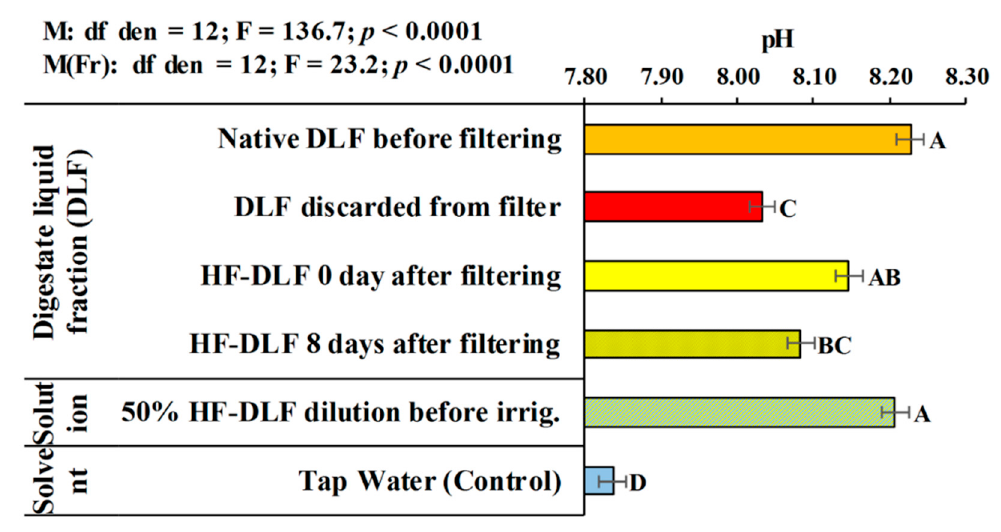
Figure 2. Values of pH of the digestate liquid fraction (DLF), before and after hydrocyclone filtering (HF), the 50% dilution of the HF-DLF, and the tap water used for the experiment. Bares are least square means (LSmeans) ± Lsmeans standard error estimates. Bars with a letter in common cannot be considered different according to a conservative Tukey-grouping applied to the p -differences of the LSmeans. Results of the statistical analysis are embedded.